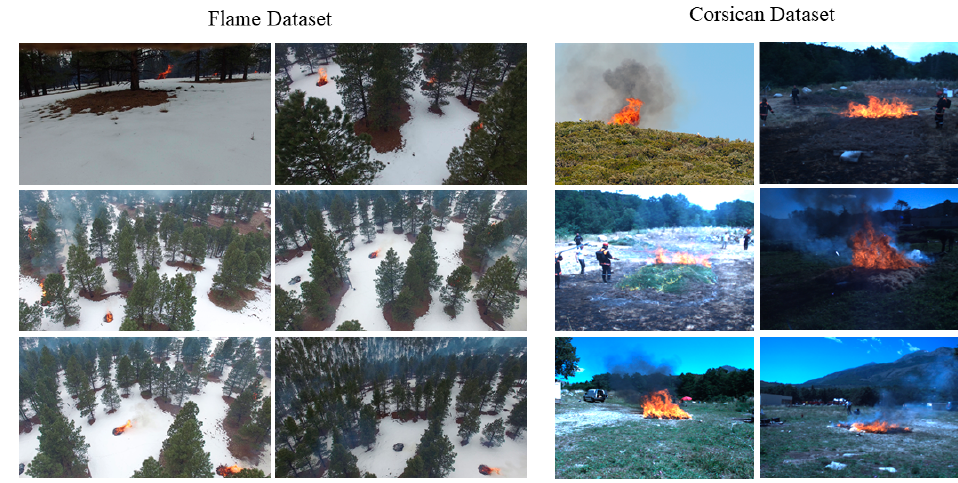
Figure 8. Selected samples from Flame dataset and Corsican dataset.